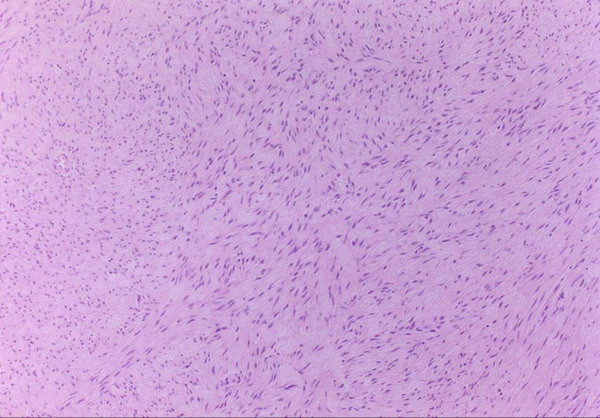
Biopsy of the multiple small nodules revealed the haphazard arrangement of uniform spindle cells in a collagenous stroma. (×100, H &E).